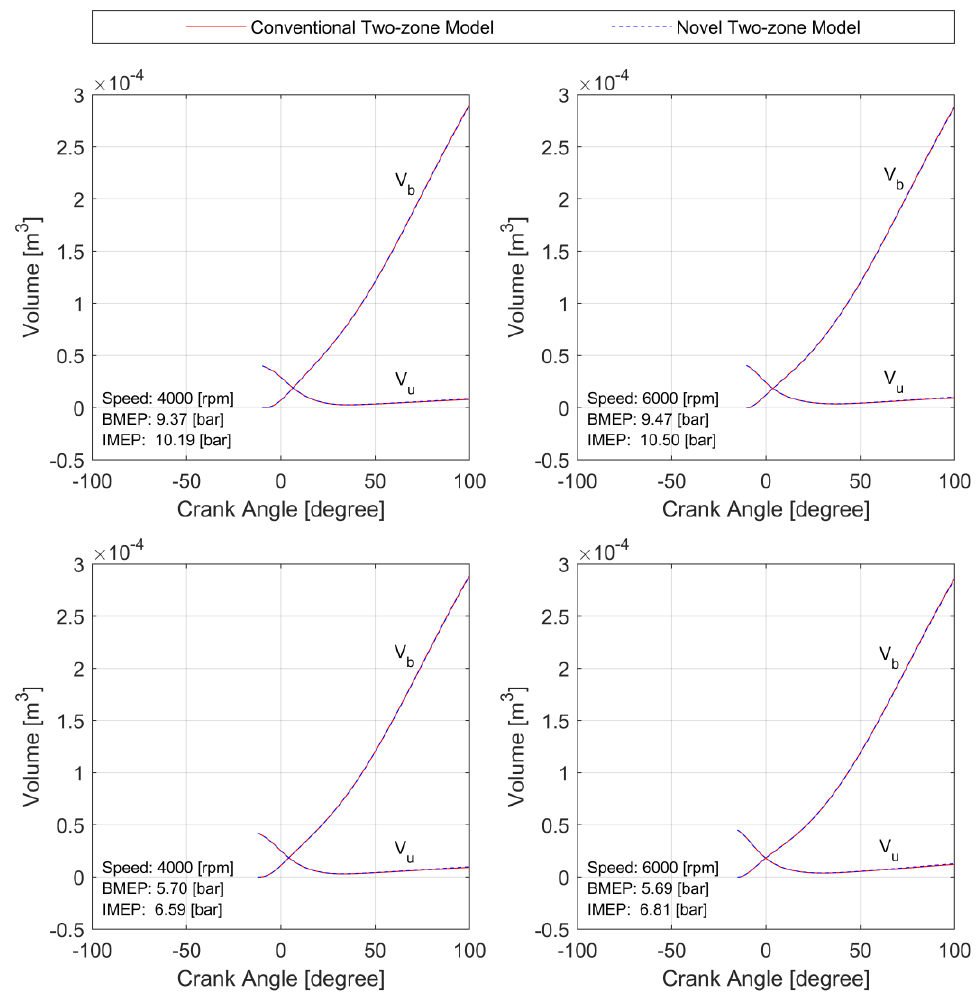
Figure 7. Simulated volume from conventional and novel two-zone model.